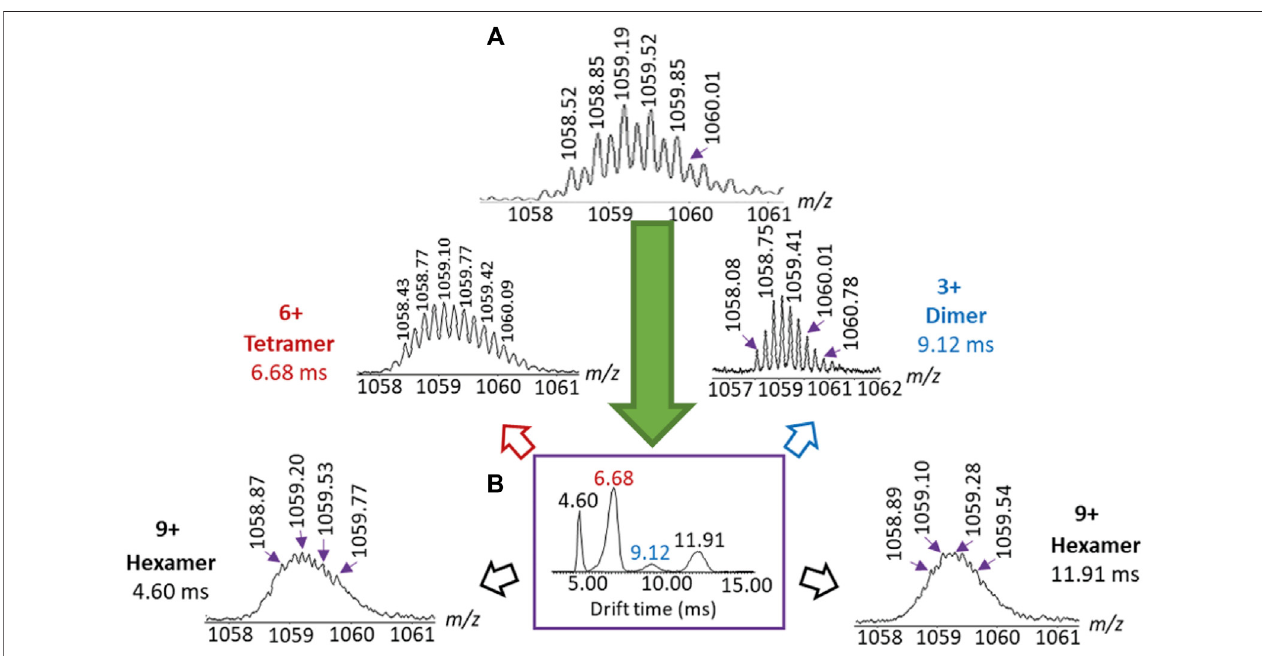
FIGURE 8| IMS-MS separates isomers and isobars and then identi fi es them by both m/z and drift time. The data shows (A) multiple MS signals around m/z 1,058 which can be separated by IM to give (B) four peaks are observed in the ion mobiligrams, two of which can be assigned tothe 9 + linear hexamer and the cyclic hexamer as well as two other isobaric 6 + and 3 + cyclic isobars Note the isobaric species are all 3 n + , as they correspond to the 3 n homologous series (Endres et al., 2020).